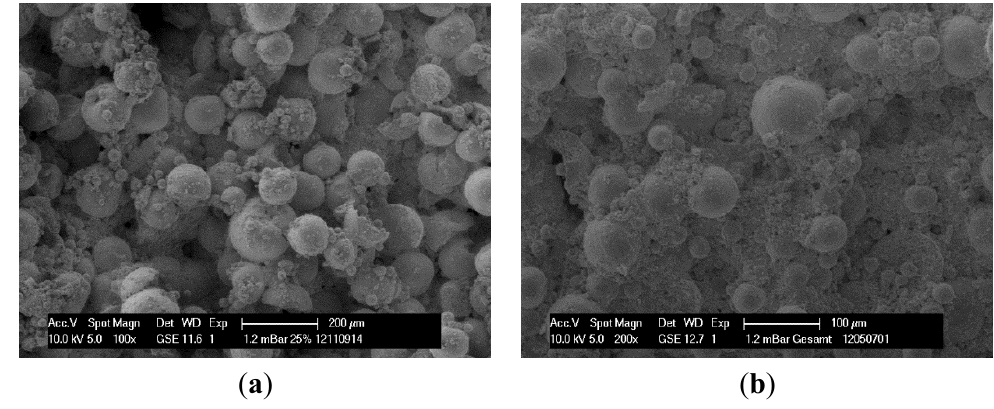
Figure 8. Specimen made of bimodal mixture >125, 25% ( a ), Specimen made of entire granule-blends (EG) with a wide particle size distribution ( b